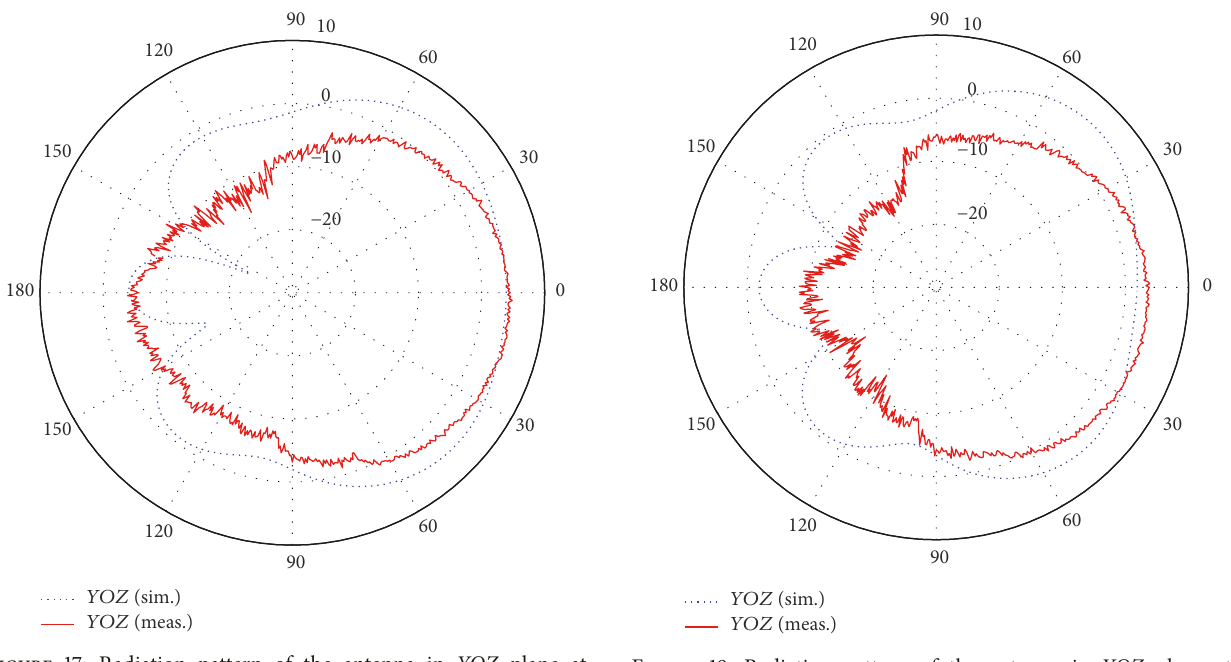
Figure 19: Radiation pattern of the antenna in YOZ plane at 5.85